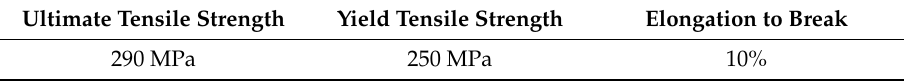
Table 1. 6082-T6 aluminum alloy chemical composition and main mechanical properties.